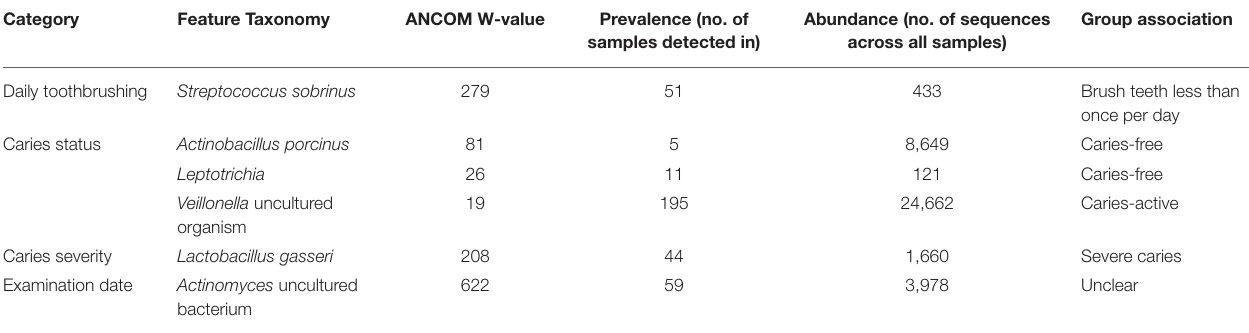
TABLE 3 | Microbial features differing significantly in abundance across groups identified by